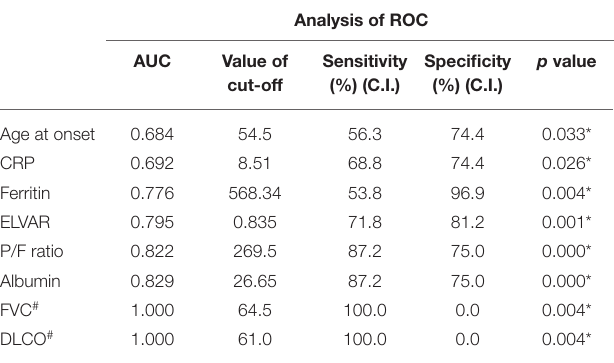
TABLE 2 | Analysis of ROC by eight significantly different indices between early death group and early survival group. Analysis of